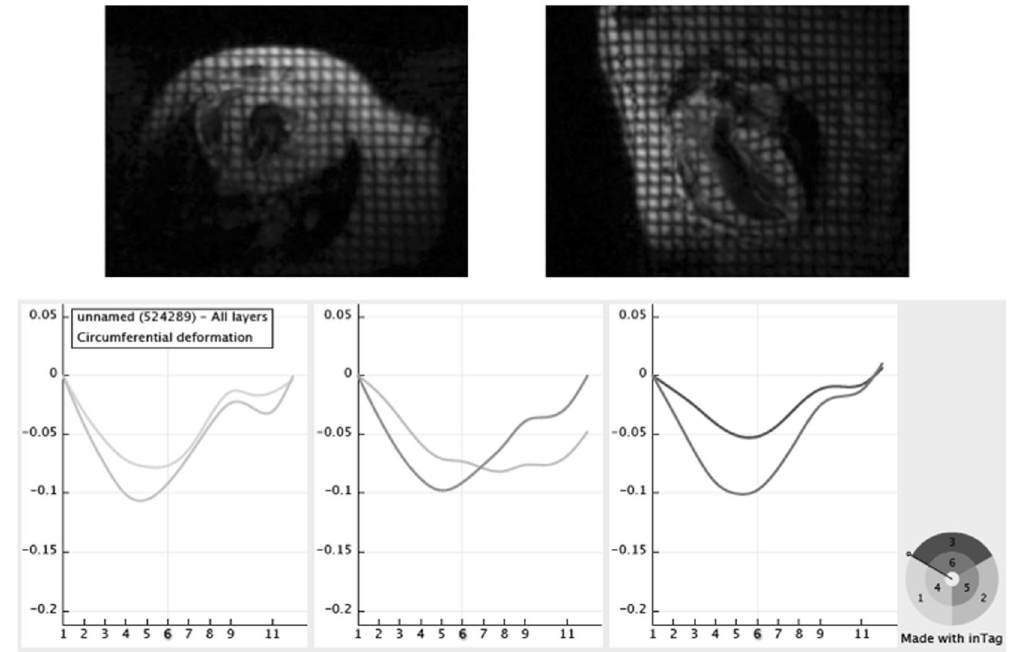
Figure 4. Sample short axis (upper left) and long axis (upper right) tagged CMR images, which were used to assess left ventricular strain. Sample circumferential strain time curves during cardiac cycle (lower panel) were obtained from short axis tagged images after post-processing using InTag plugin OsiriX ®